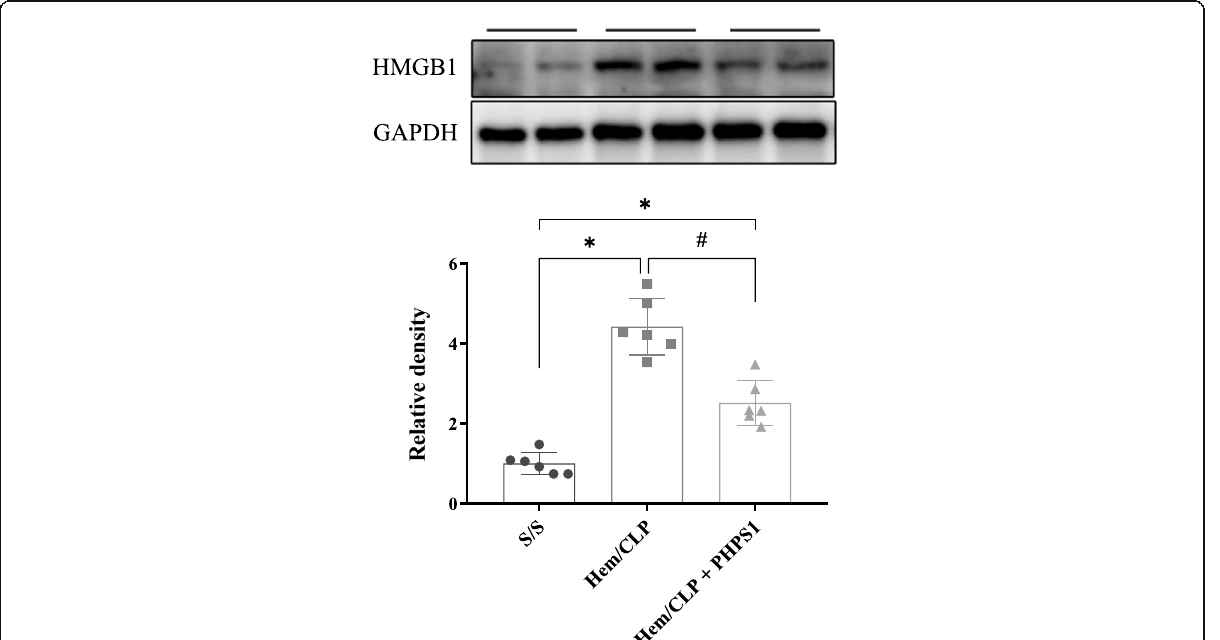
Fig. 6 Effects of PHPS1 on expression of HMGB1 in kidney after Hem/CLP. The kidneys were collected 24 h post Hem/CLP or Sham operation and tissue homogenates were obtained. The expression of HMGB1 was determined by western blot. The levels of HMGB1 from Hem/CLP mice was significantly increased compared to Shams. PHPS1 treated Hem/CLP mice showed reduced HMGB1 levels compared to Veh treated HEM/CLP mice. *, P < 0.05, versus Sham (S/S); #, P < 0.05, PHPS1 treated group (Hem/CLP + PHPS1) versus Hem/CLP + vehicle (Hem/CLP). One-way ANOVA and a Student-Newman-Keuls ’ test, Mean ± SD; n = 6